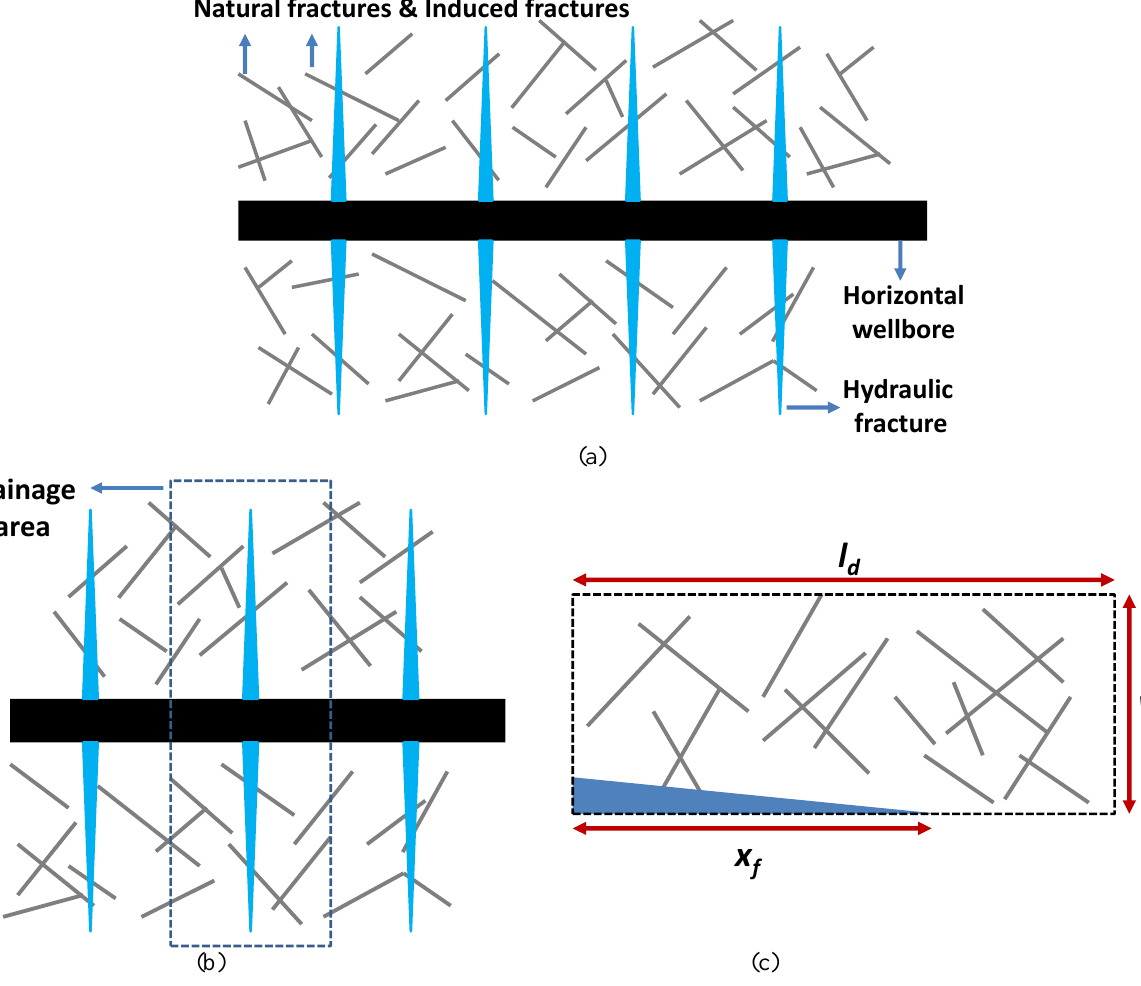
Figure 1—Illustrations of the fracture system and matrix, the drainage area of a hydraulic fracture, and the problem